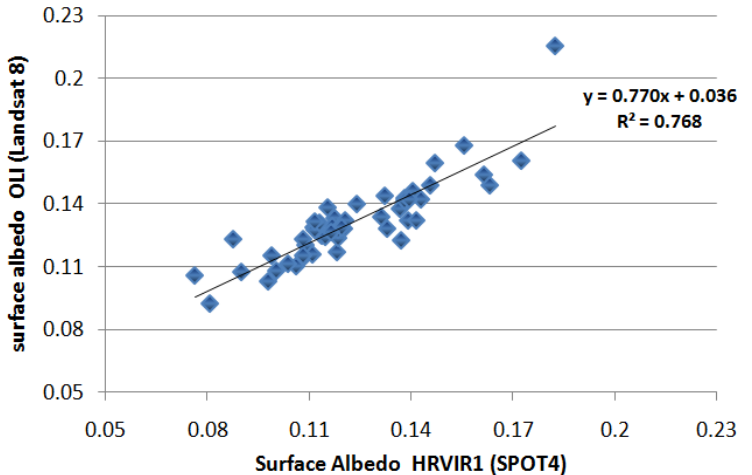
Figure 3. Scatter plot of the estimated ( r ) by HRVIR1 (High Resolution in Visible and Infrared) vs. OLI (Operational Land Imager); Faregh district, 26 April 2013.